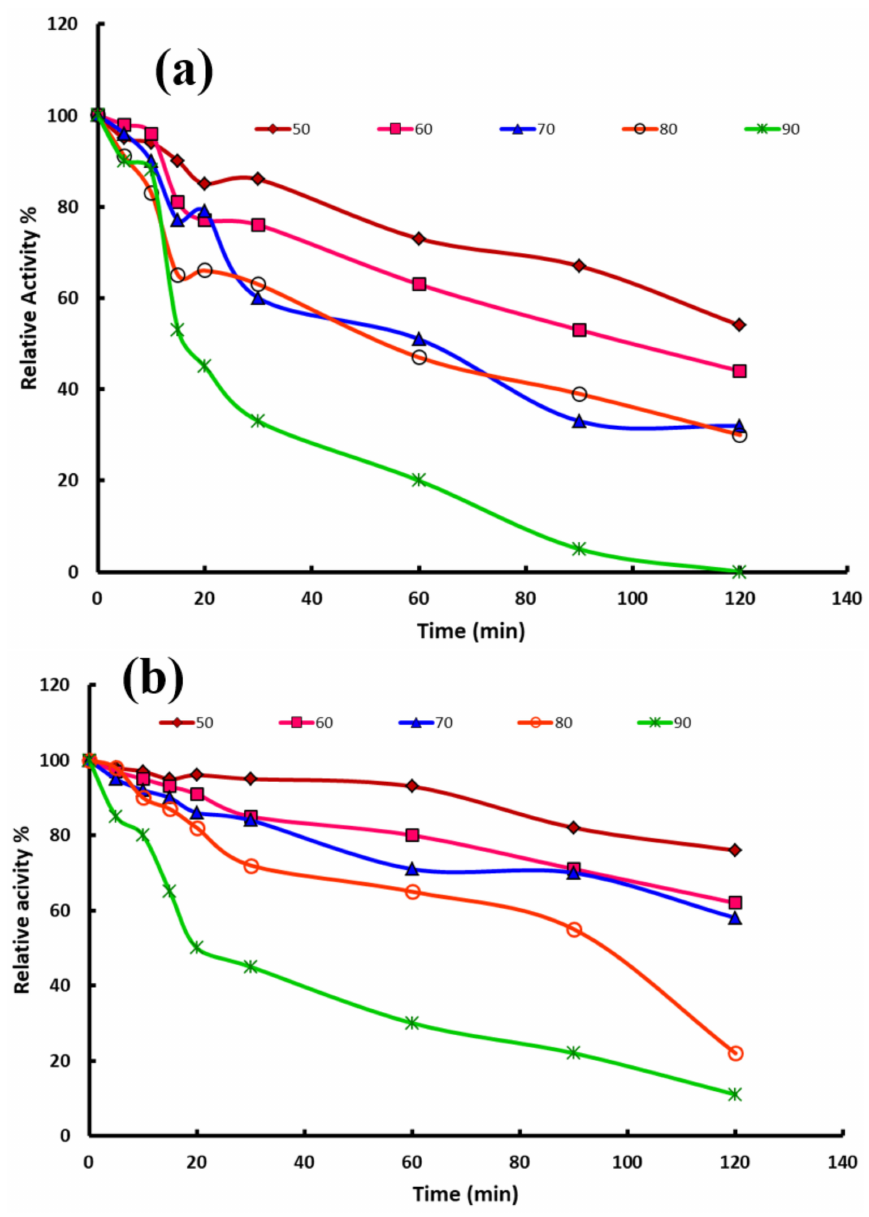
Figure 4. Thermo-stability of the partially purified free enzyme ( a ) and immobilized lipase ( b